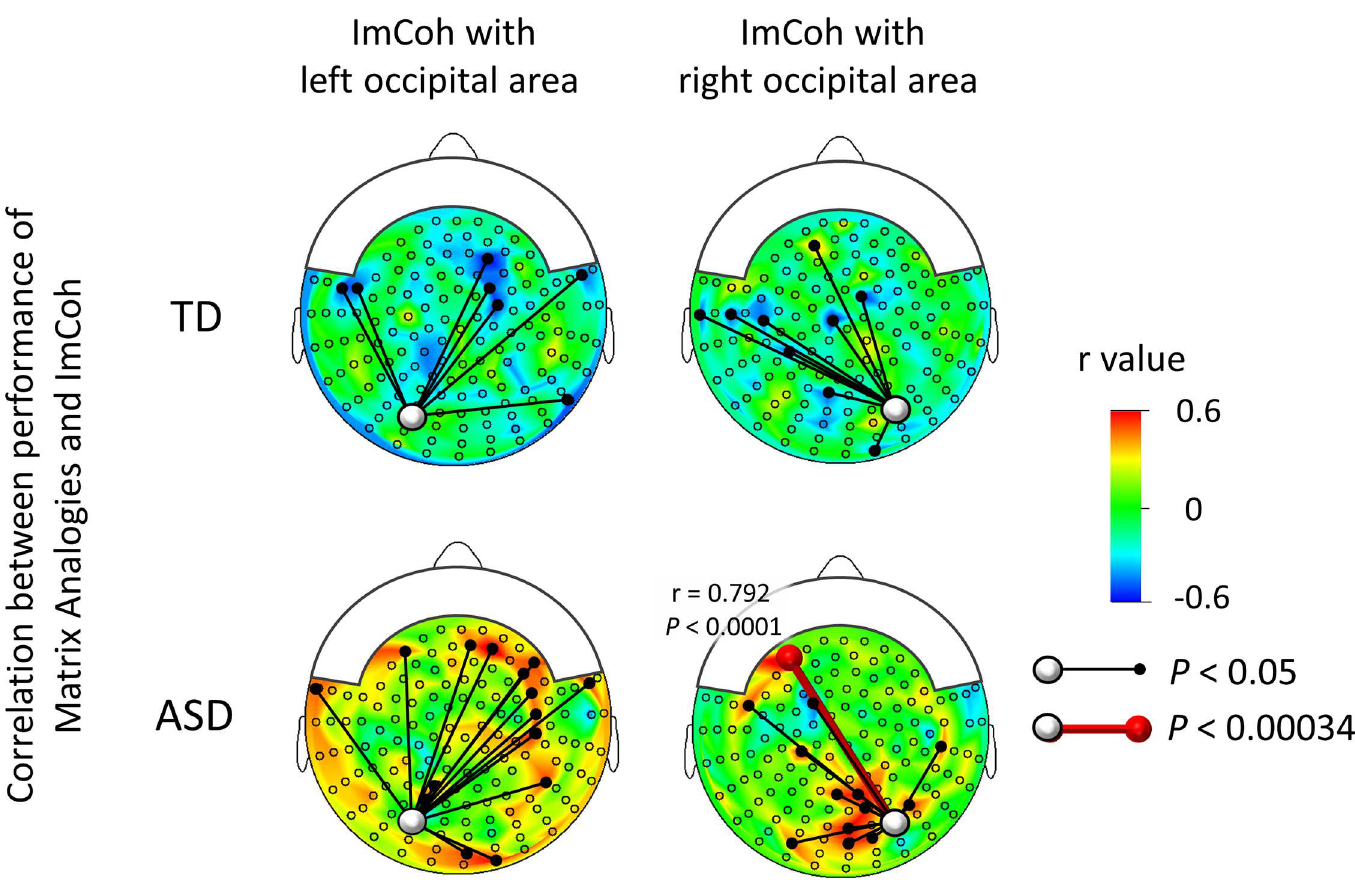
Fig 5. Correlation betweenperformance on MatrixAnalogiesand ImCoh. In TD children(upperrow), therewere no significant correlations for any sensor pair (i.e., alpha < 0.00034).In AS children(lower row), therewas a significant positive correlation for one sensor pair (redlines);rightoccipital–left frontalpair (r = 0.792,P < 0.0001).ImCoh:imaginary coherence.